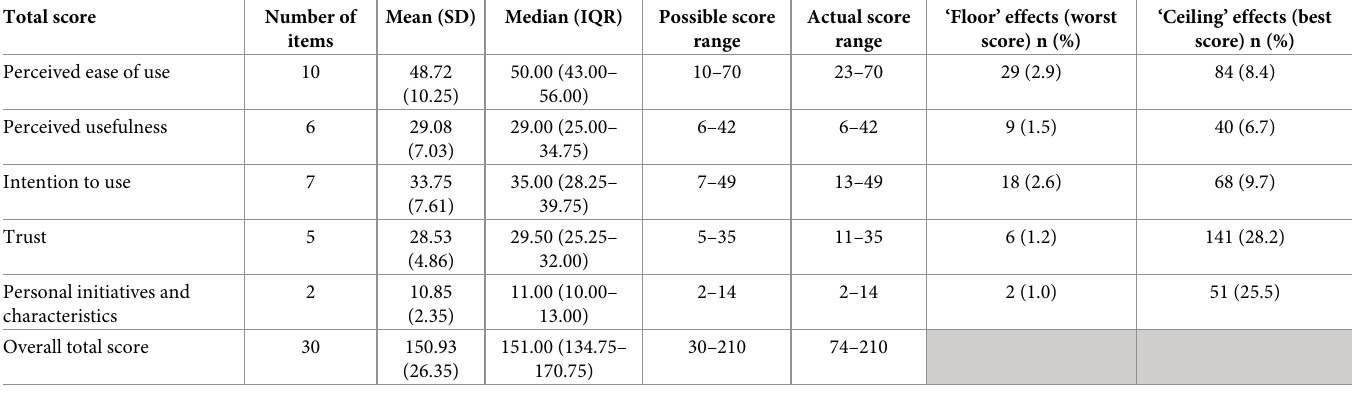
Table 2. Descriptive statistics and score distributions of the survey constructs for